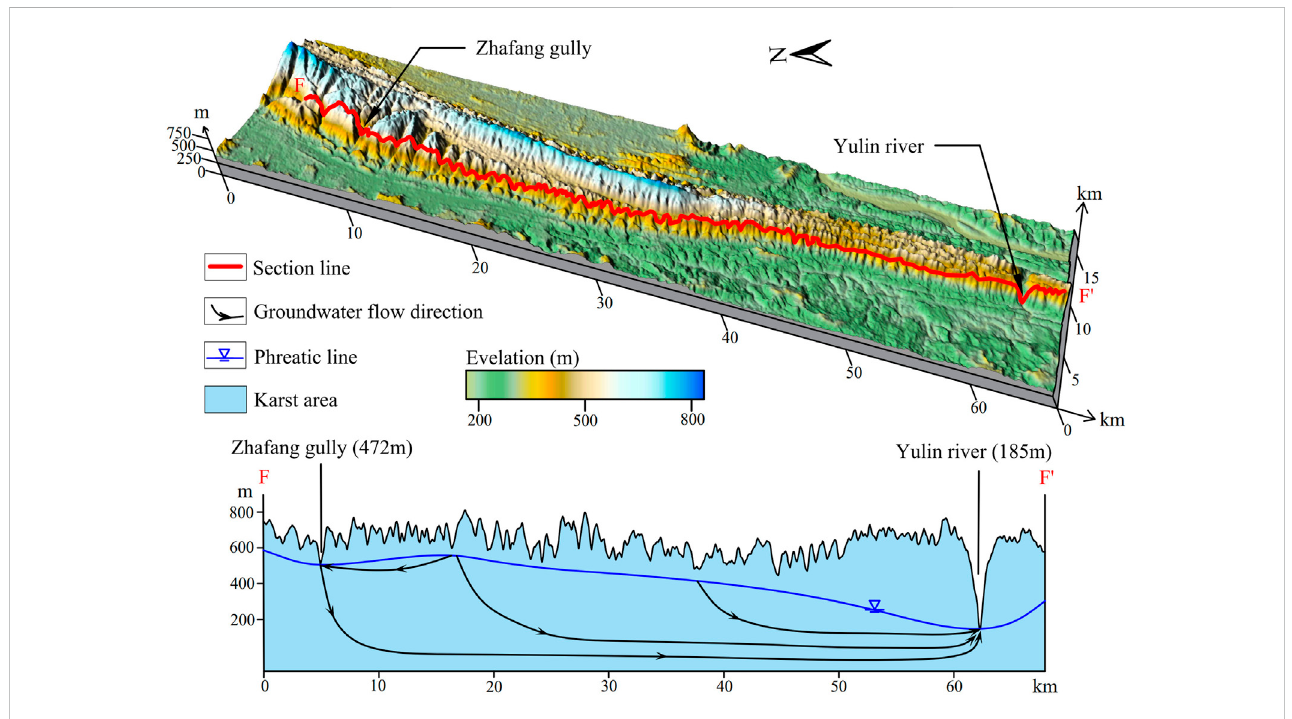
FIGURE 9 Karst water circulation pattern in south section of